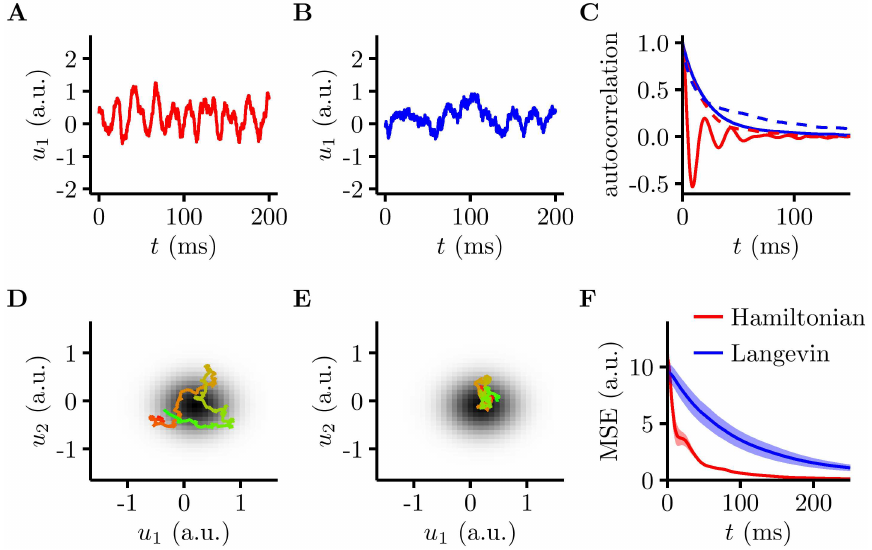
Fig 4. The Hamiltonian sampleris more efficient than a Langevin sampler. A, B. Examplemembrane potential traces for a randomly selectedneuronin the Hamiltoniannetwork ( A ) and the Langevinnetwork ( B ). C. Solid lines: the autocorrelation of membranepotentialtraces in A and B , for Hamiltonian (red) and Langevin samplers (blue). Dashedlines: the autocorrelation of the joint (log) probabilityfor Hamiltonian(red) and Langevin samplers (blue). Note that for the Hamiltoniansampler, the joint probabilityis over both u and v . D, E. Joint membrane potential traces from two randomly selectedneuronsin the Hamiltoniannetwork ( D ) and the Langevinnetwork ( E ), colour indicatestime (from red to green, spanning25 ms), grey scale map shows the (logarithmof the) underlying posterior (its marginalover the two dimensions shown). F. Normalised mean square error (MSE) between the true mean and the mean estimate from samples taken over a time t for the Langevin (blue) and Hamiltoniandynamics(red), with 100 repetitions(mean ± 2